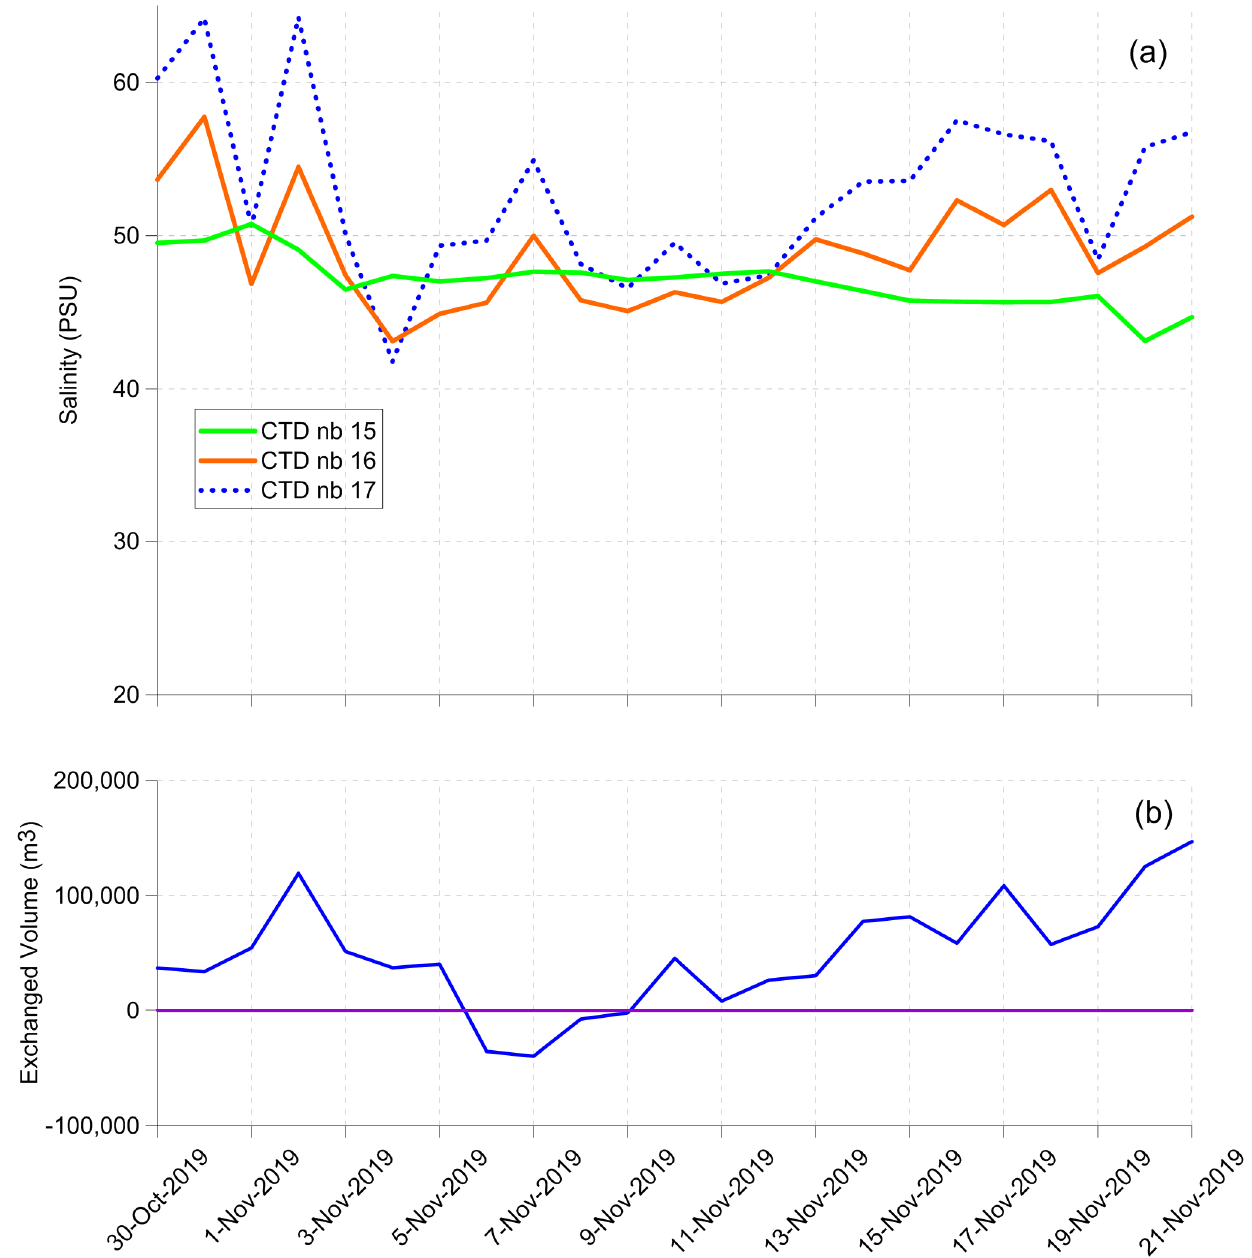
Figure 6. ( a ) Daily averaged salinity measured at locations 17, 18, and 19 (Figure 2) from 30 October 2019 to 21 November 2019. ( b ) Cumulative daily volume of water through the sluice gate at La Comtesse. A positive volume corresponds to a flow entering the Lion/Dame lagoon. The purple line is informative, to highlight the zero value in figure ( b ).